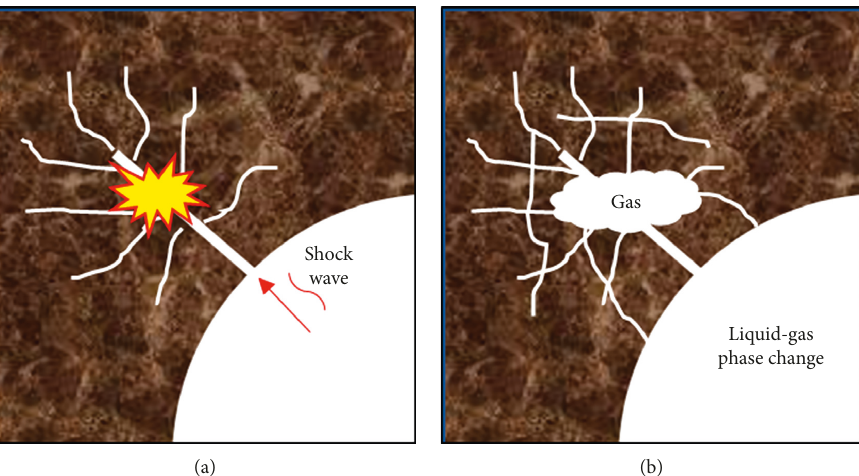
Figure 1: (a) The shock wave causes longitudinal cracks, and (b) the explosive gas expands to cause lateral cracks, thereby destroying the rockmasses.